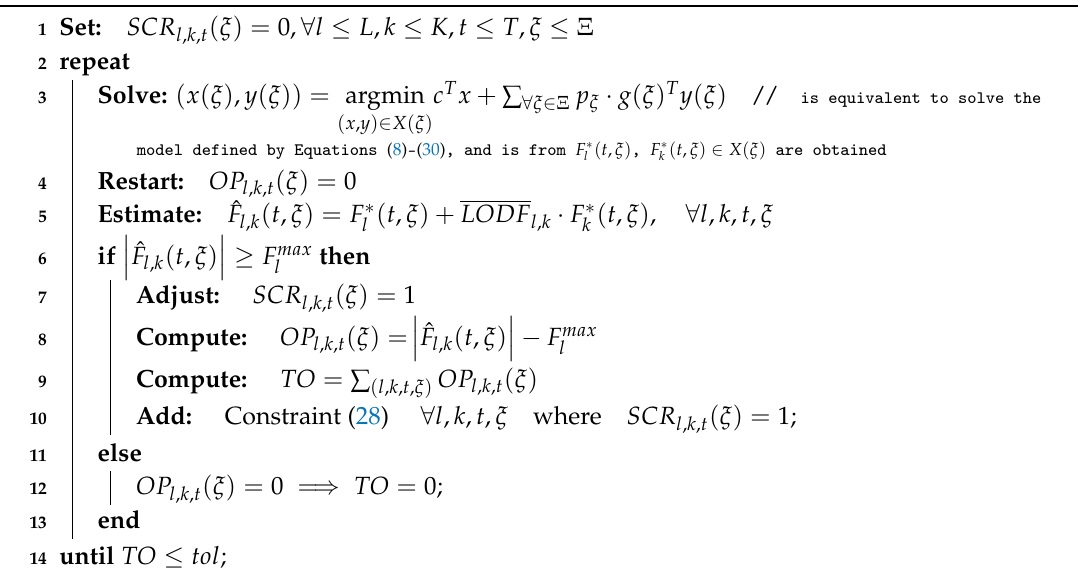
Algorithm 1: Method for Adding N − 1 Security